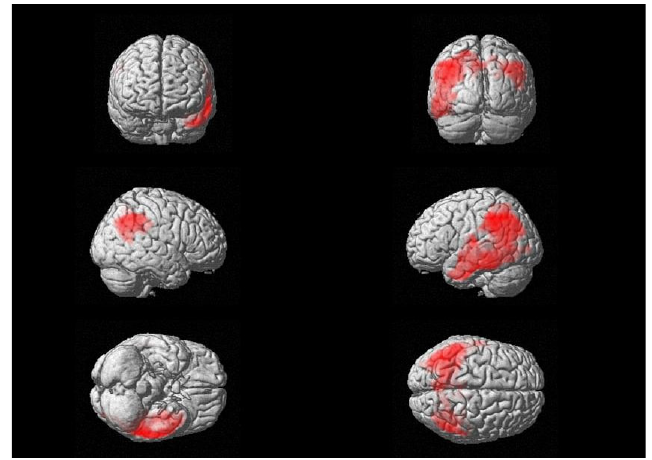
Figure 2. Three-dimensional brain rendering showing clusters obtained in SPM regression analysis for the negative correlation between CSF β -S100 and brain 18 F-FDG uptake (see Table 3). Table 3. Multiple regression analysis showing the CSF β -S100 related areas of decreased 18 F-FDG brain uptake (negative correlation), corrected for age, sex and CSF levels of t-tau.